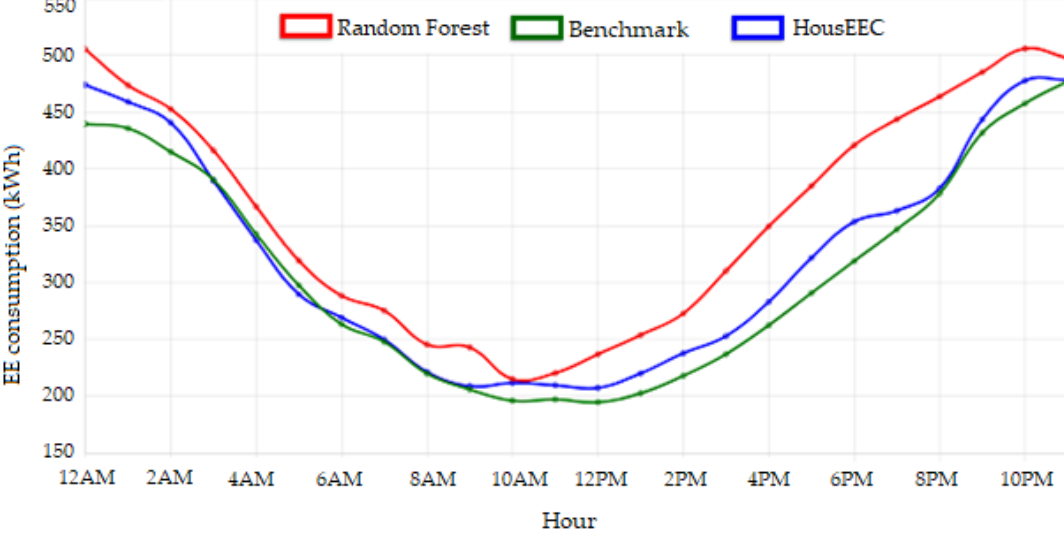
Figure 13. Aggregated hourly predictions of EE consumption for the next day.